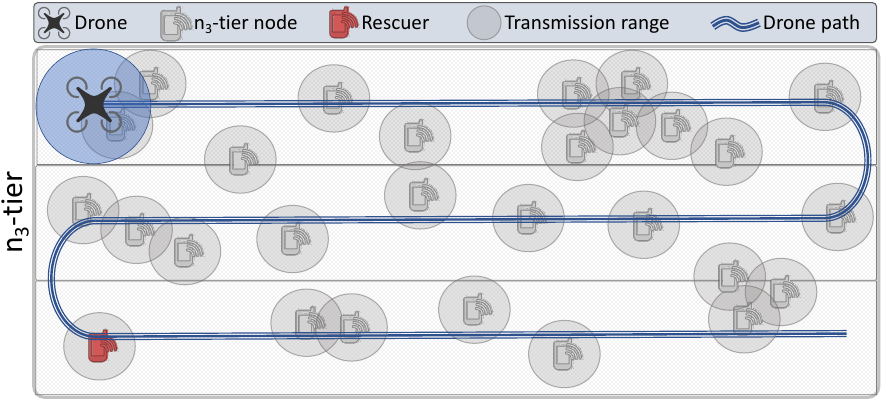
Figure 5. During the search phase a drone flies over the area affected by a disaster and stores the location of the discovered nodes in the highest (i.e., n 3 ) tier of the network.